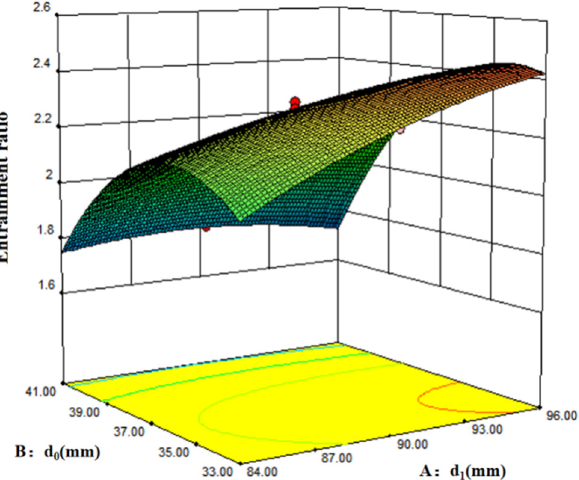
Figure 3. Response surface diagram of the influence of A and B on the entrainment ratio.